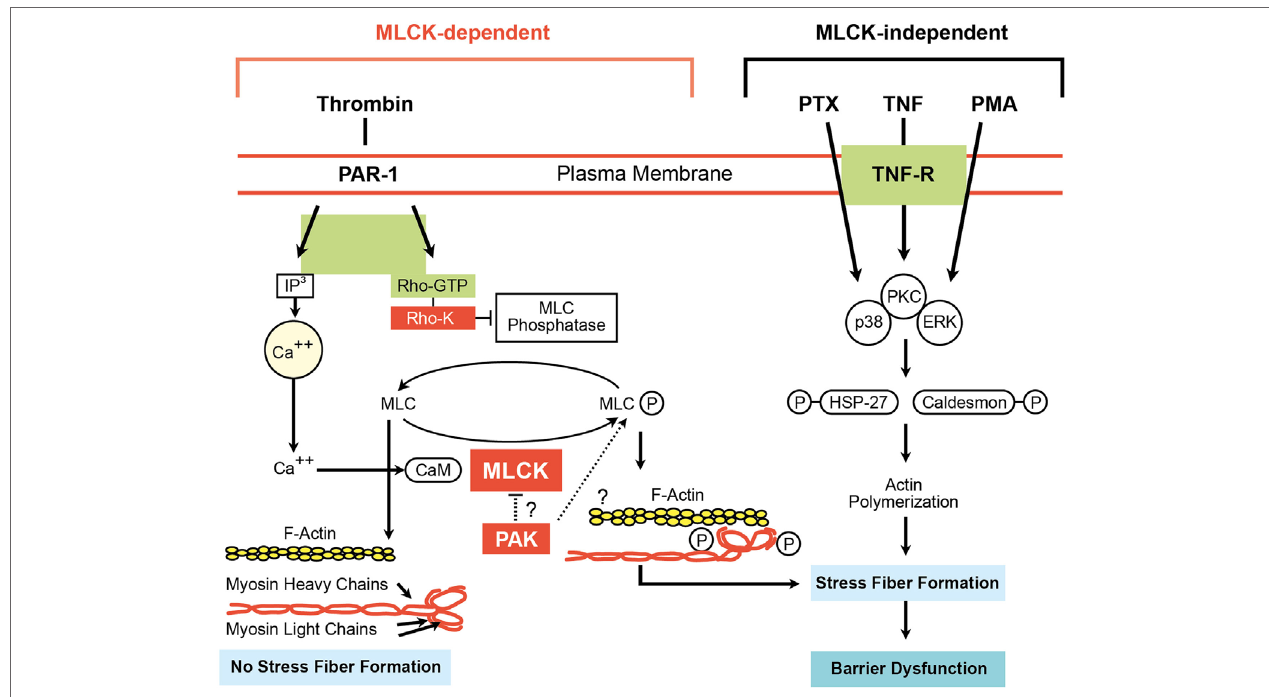
FigURe 5 | Myosin light chain kinase (MLCK)-dependent and MLCK-independent pathways involved in endothelial cell (EC) barrier dysfunction (66). Adapted from Ware and Matthay